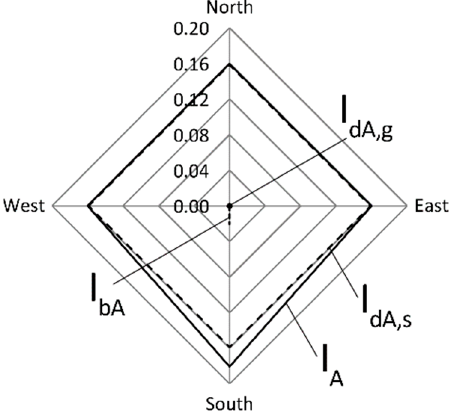
Figure 2. Erythemal UV irradiances received, in the analysed conditions, by vertical surfaces facing the four cardinal points.